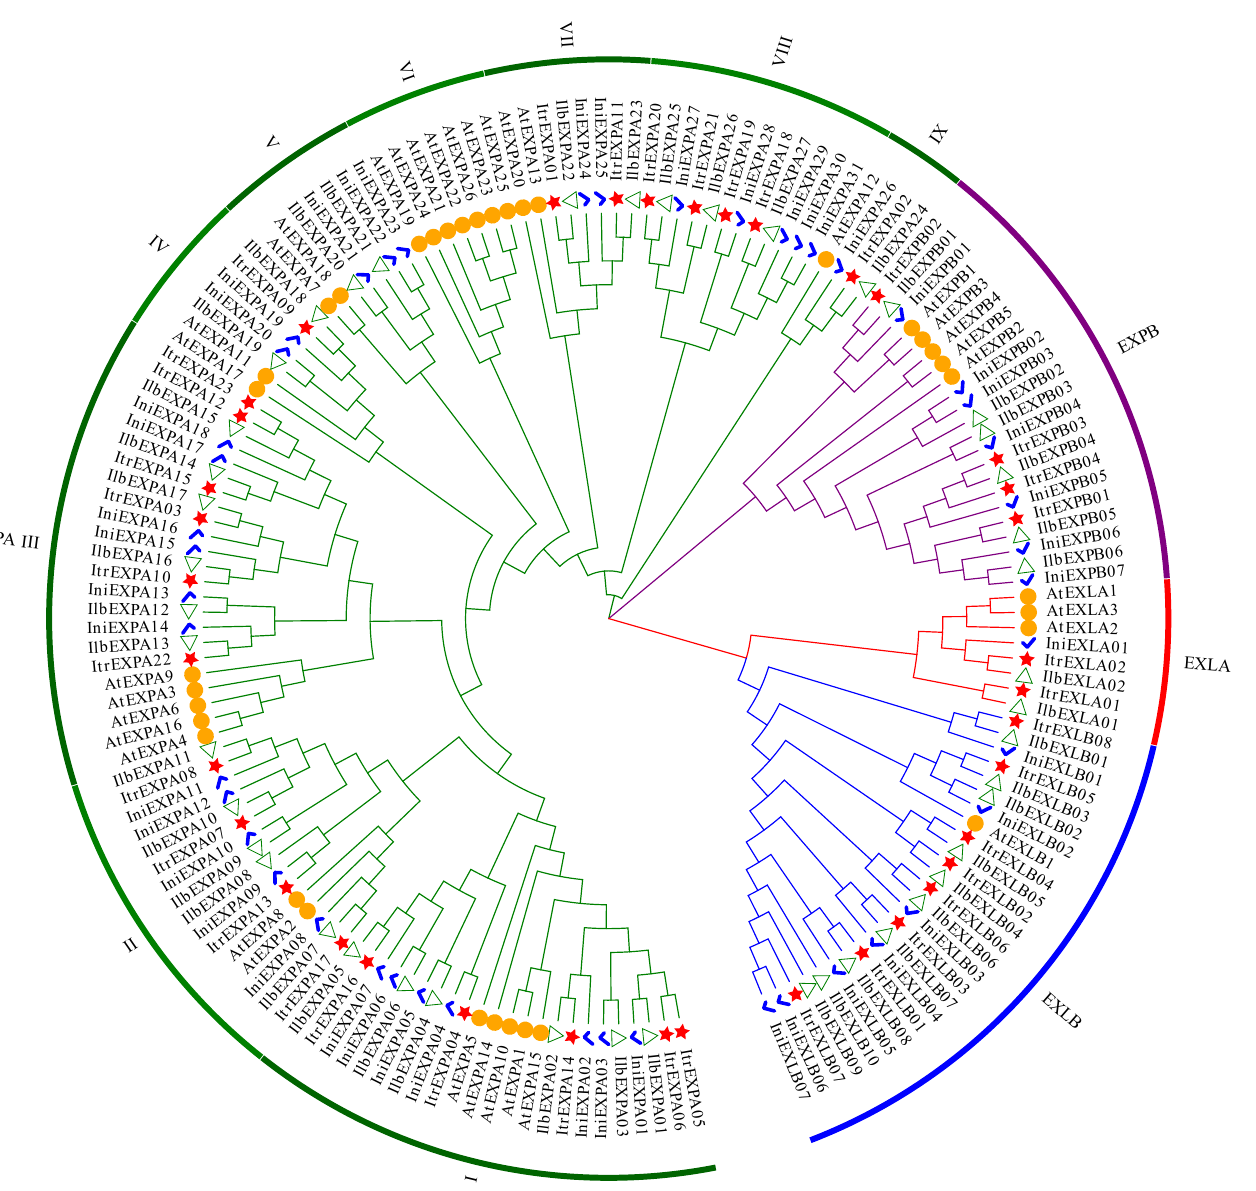
Figure 1. Phylogenetic tree of expansin proteins. The phylogenetic tree was constructed by using the sequences of all expansin proteins in Y22 (Itr: 37), I. nil (Ini: 46) (Table S2), I. triloba (Ilb: 45) (Table S2) and A. thaliana (AT: 35). The genes of the same species are highlighted by the same marker and color. Red stars: Y22, Blue checkmarks: I. nil , Green empty triangles: I. triloba , Orange circles: A. thaliana . The subclass labels I to IX of EXPA are alternately marked with dark green and